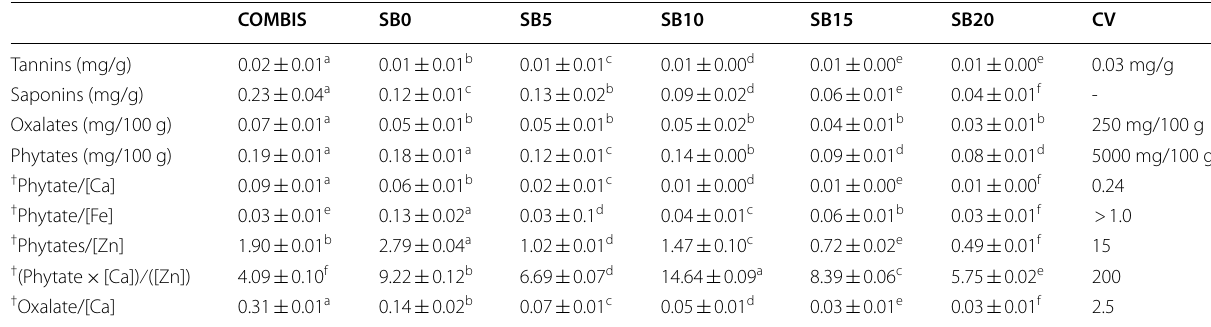
Table 4 Anti-nutrients composition and anti-nutrient mineral molar ratios of shallot-enriched plantain biscuits